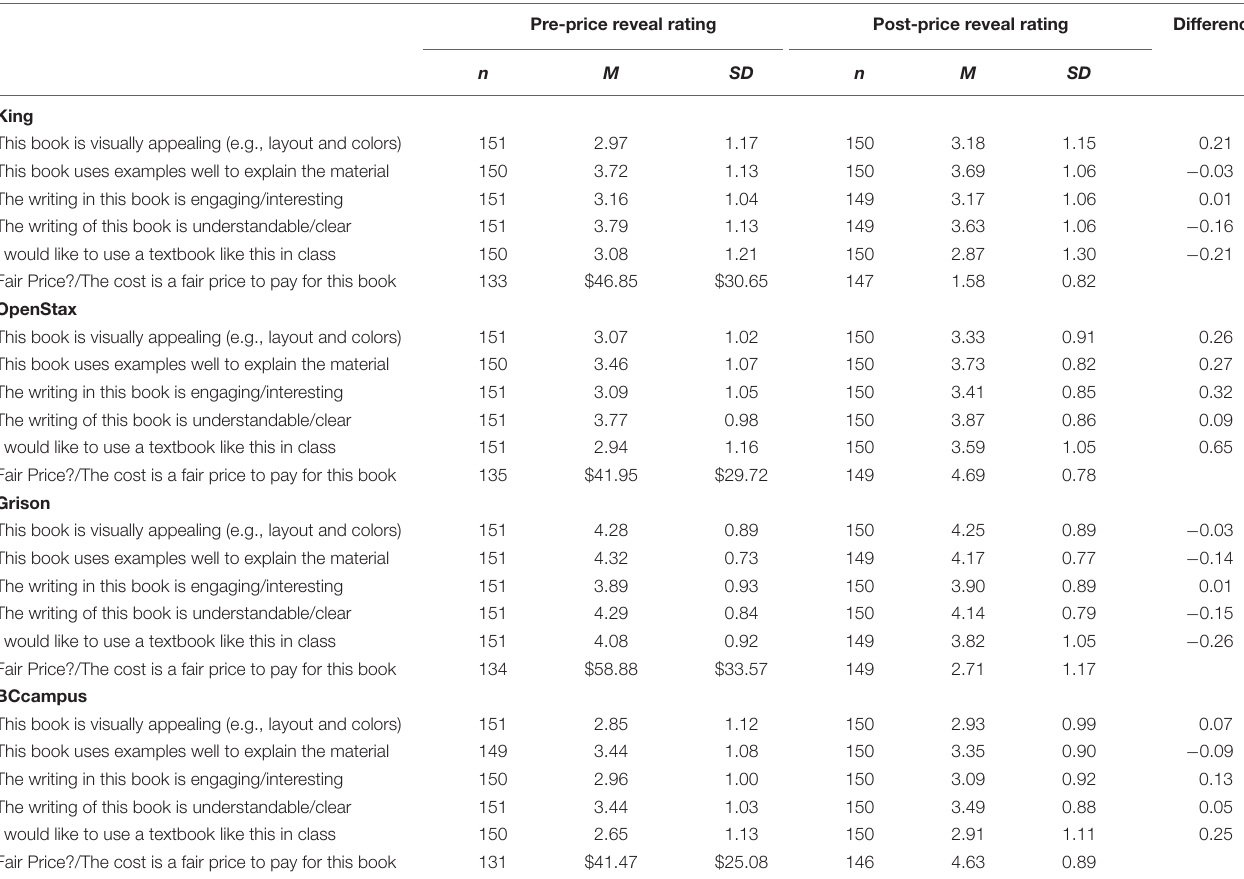
TABLE 1 | Student quality ratings of textbook samples.